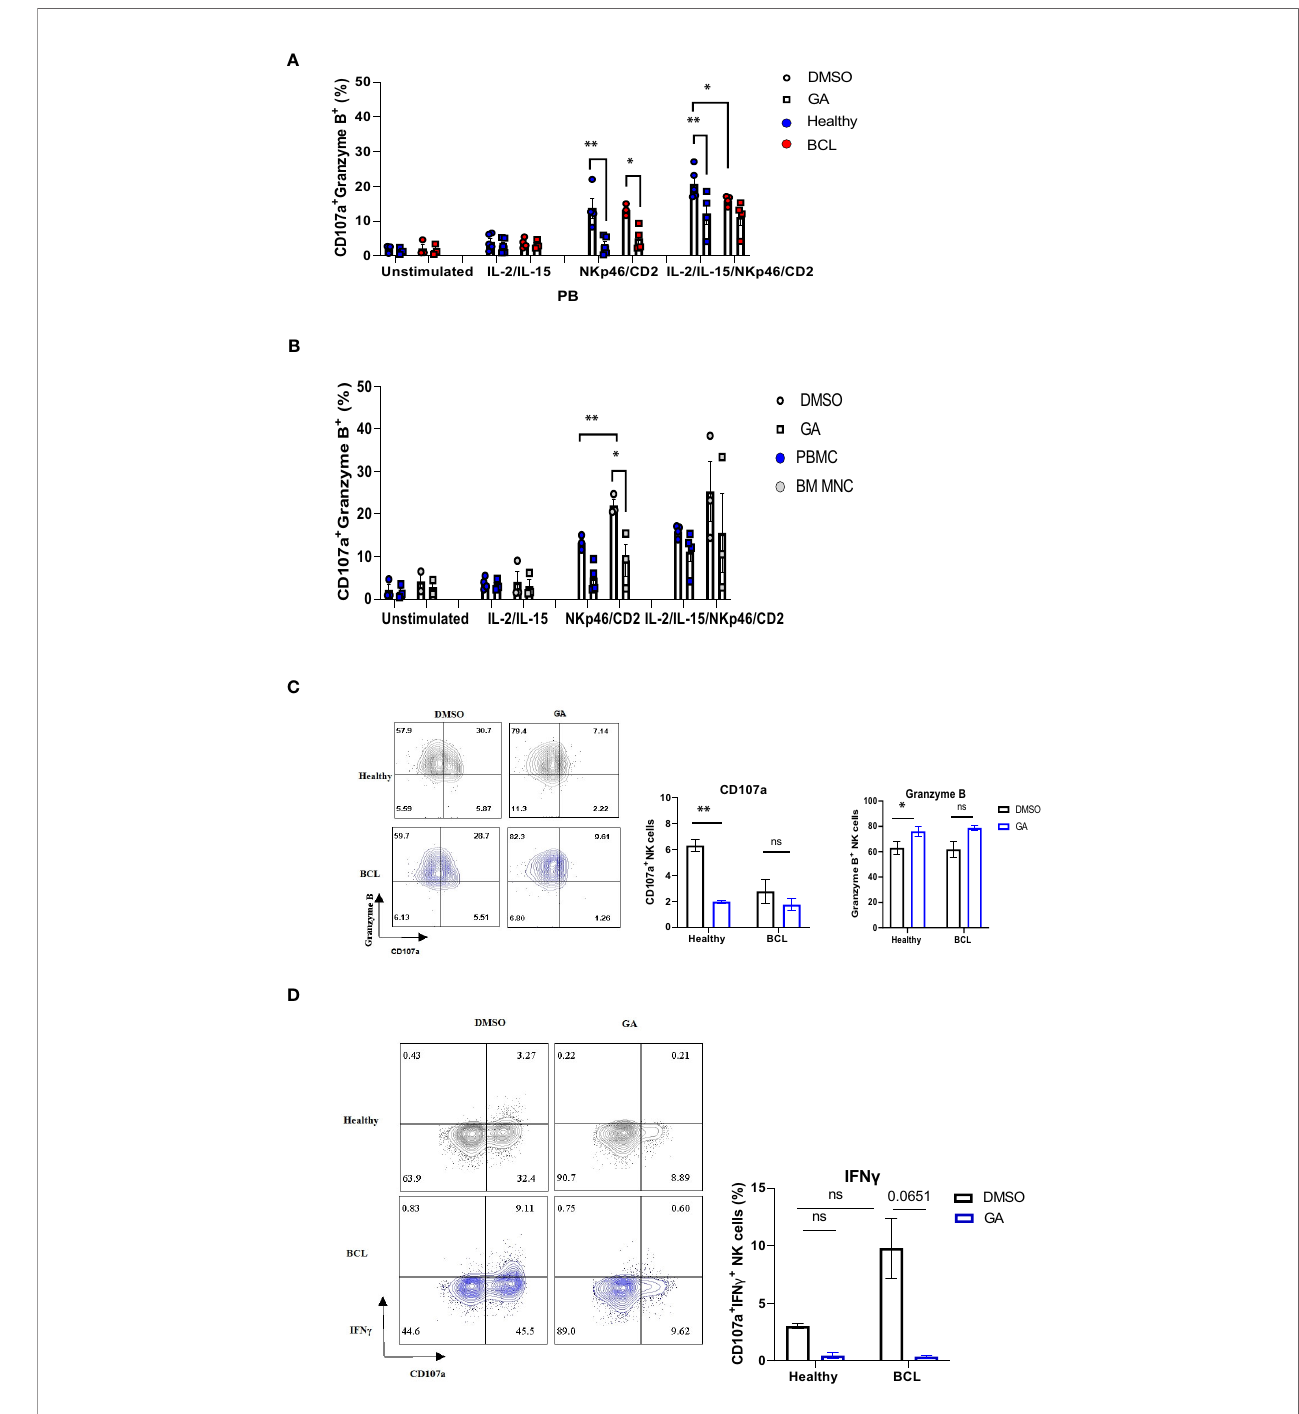
FIGURE 7 | The effect of HSP90 inhibition on the NK cell degranulation response, granzyme B and IFN g production in lymphoma patients. NK cell degranulation, as measured by CD107a surface expression, and granzyme B/IFN g production in PB (n=4) of lymphoma patients and healthy controls (n=5) and BM (n=3) of lymphoma patients. PBMC (A) and BM MNC (B) were pre-treated with geldanamycin (0.1µM) or DMSO in the presence of IL-2 (100IU/ml) and IL-15 (10 ng/ml) and stimulated with anti-NKp46/anti-CD2. (C) Representative fl ow cytometry plots of CD107a + /Granzyme B + double positive NK cells on the left and the frequency of CD107a single positive (SP) and Granzyme B SP NK cells in response to IL-2/IL-15 and anti-NKp46/anti-CD2 stimulation. (D) Representative fl ow cytometry plots of CD107a + IFN g + NK cells on the left and the frequency of CD107a + IFN g + NK cells in response to IL-2/IL-15 and anti-NKp46/anti-CD2 stimulation. Graphs show mean ± SEM. ns, not signi fi cant, *p<0.05, **p< 0.01. GA, Geldanamycin; BCL, B-cell